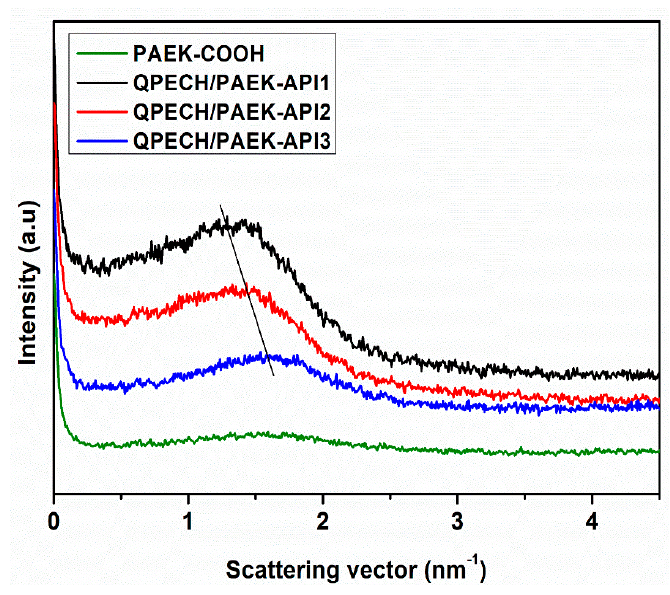
Figure 7. SAXS patterns of QPECH / PAEK-API membranes.